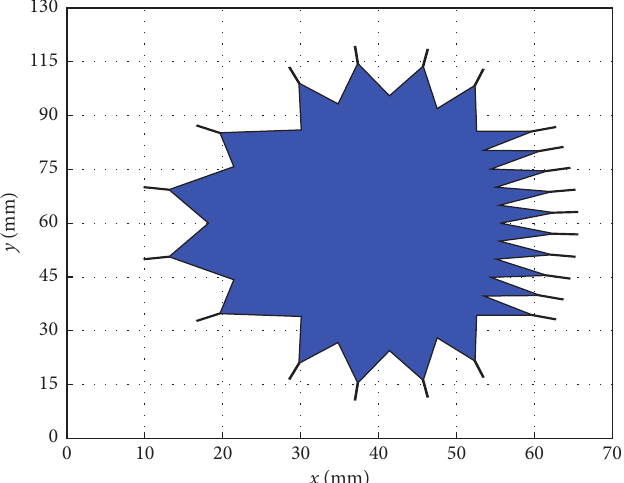
Figure 10: C-band Rotman lens